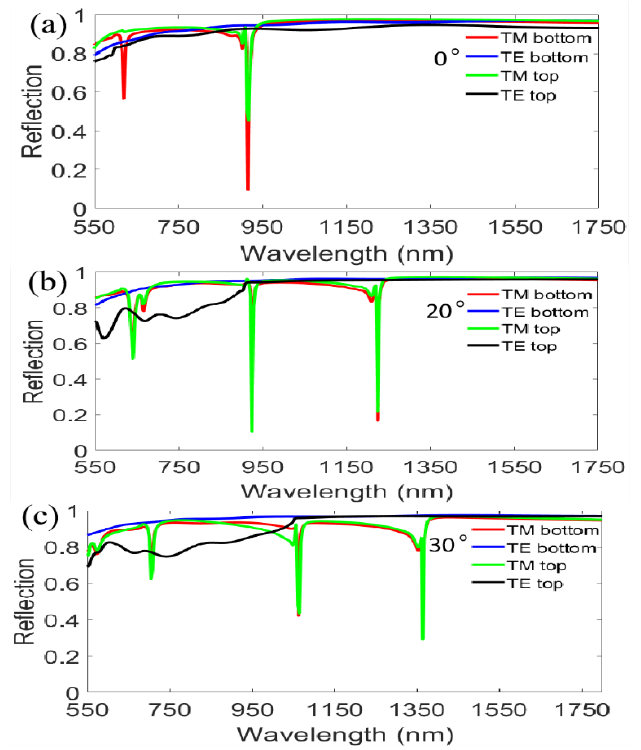
Figure 3. Reflection spectra of the designed nanograting with TM and TE polarized illuminations from the bottom and the top under different incident angles of ( a ) 0°; ( b ) 20° and ( c ) 30°.